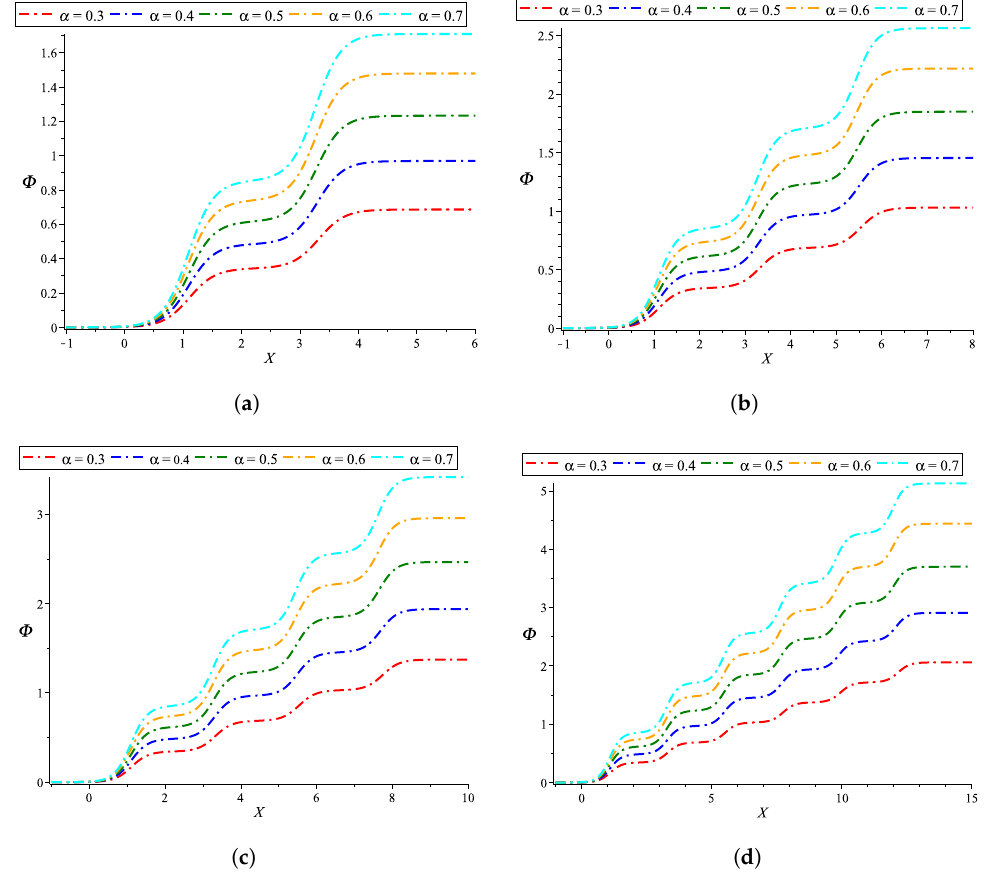
Figure 6. Effect of α on the electrostatic ( a ) single-, ( b ) overtaking collision of double-, ( c ) overtaking collision of triple-, and ( d ) overtaking collision of four–shock wave excitations, respectively, by choosing p = 0.45, M r = 3.75, T ni = 0.05, T e = 0.2, N r 1 = 0.5, N r 2 = 0.02, µ ni = 0.01, and µ pi =